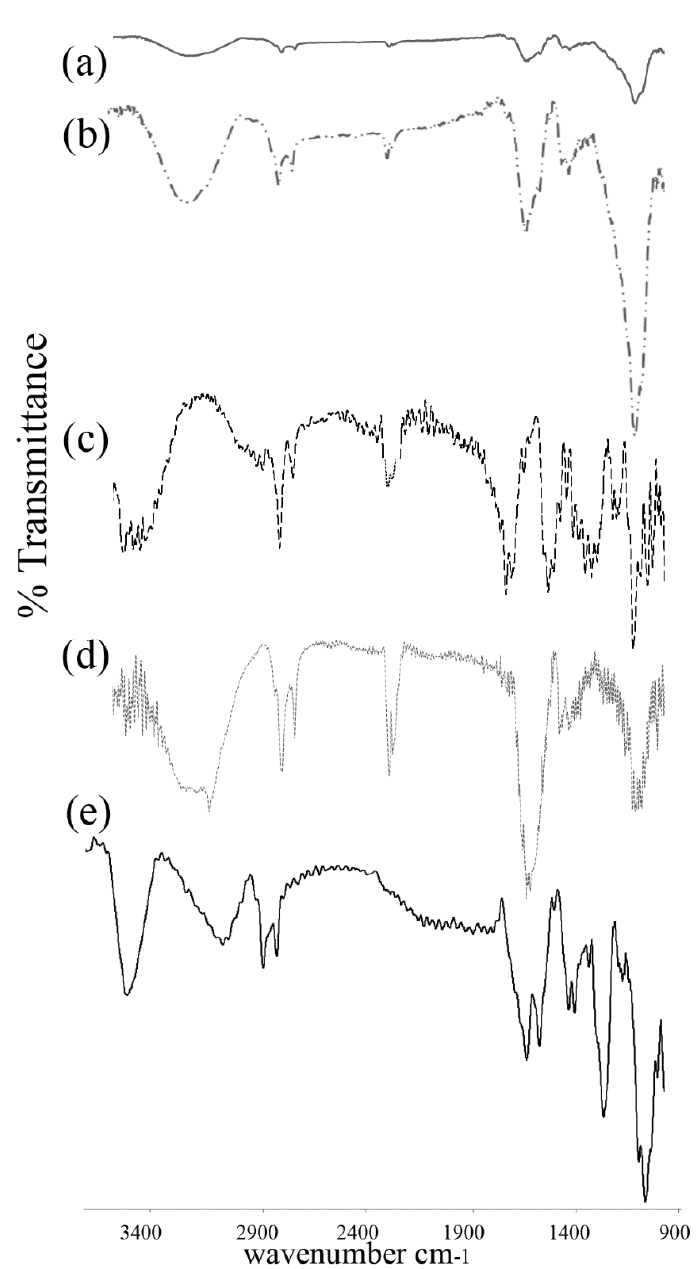
Figure 4. Comparison of FTIR spectra of each incorporated layer in Construct II. ( a ) FVC